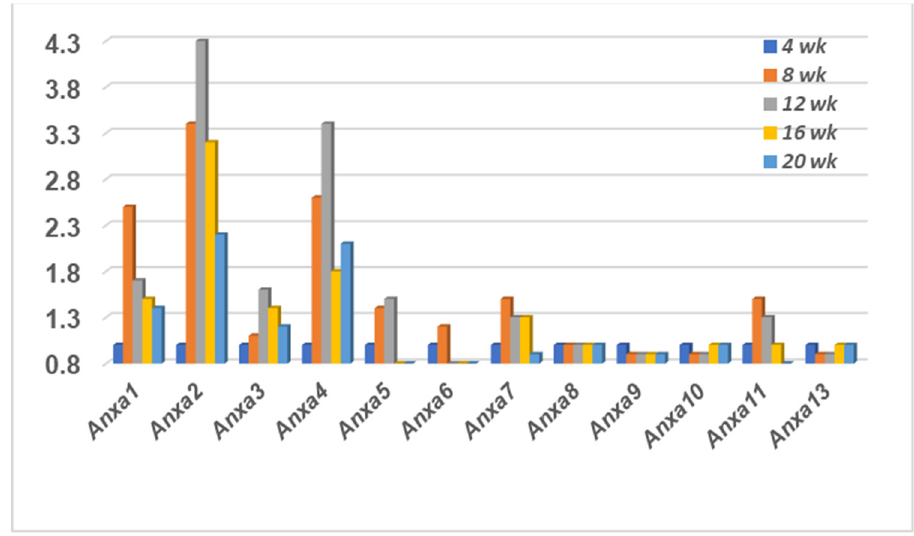
Figure 2. Transcriptome profile of genes encoding the annexin family proteins. Temporal transcriptomic expressions of annexin genes in the lacrimal glands of SS S C57BL/6.NOD ‐ Aec1Aec2 mice.